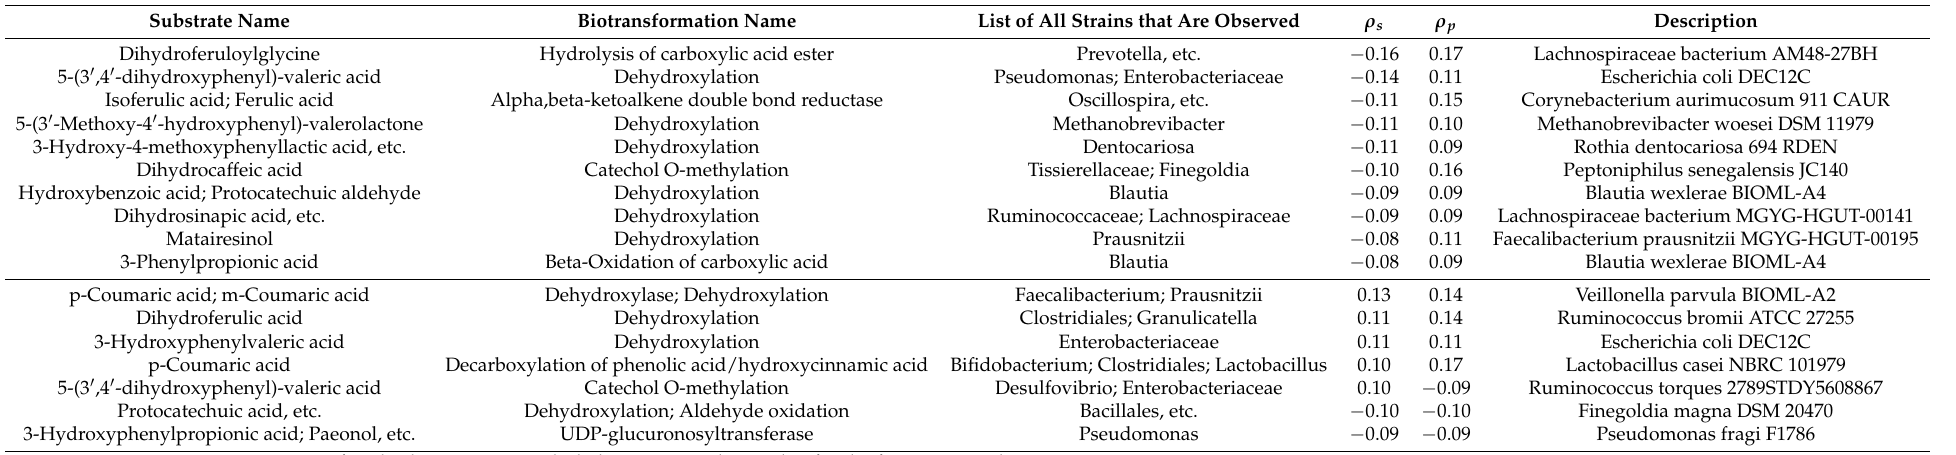
Table 1. TransDiscovery identified 17 biotransformations. The columns ρ s and ρ p represent Spearsman’s rank correlation coefficients between the microbial features and substrate or product, respectively. The top biotransformations hold negative/positive biotransformations between substrates/products and microbial features, and the bottom ones do